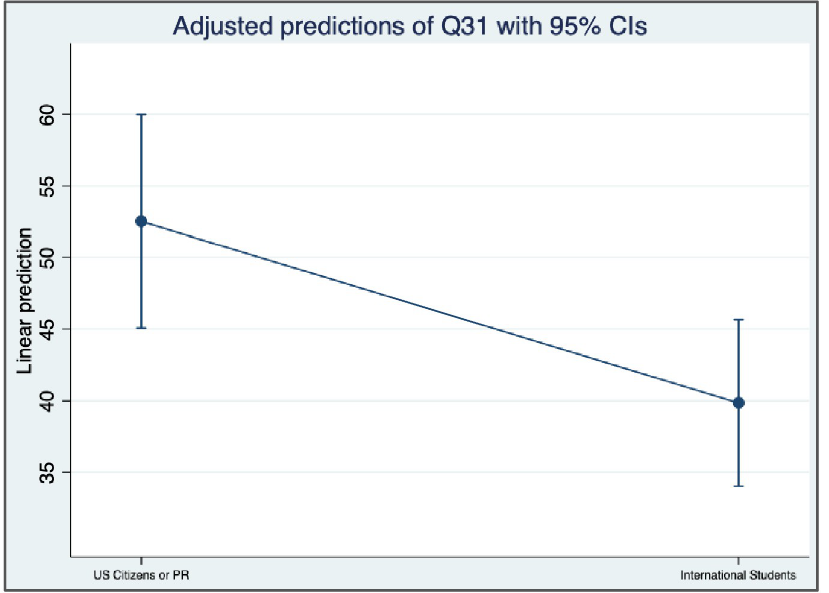
Fig 6. Confidence level difference between U.S. citizens and international